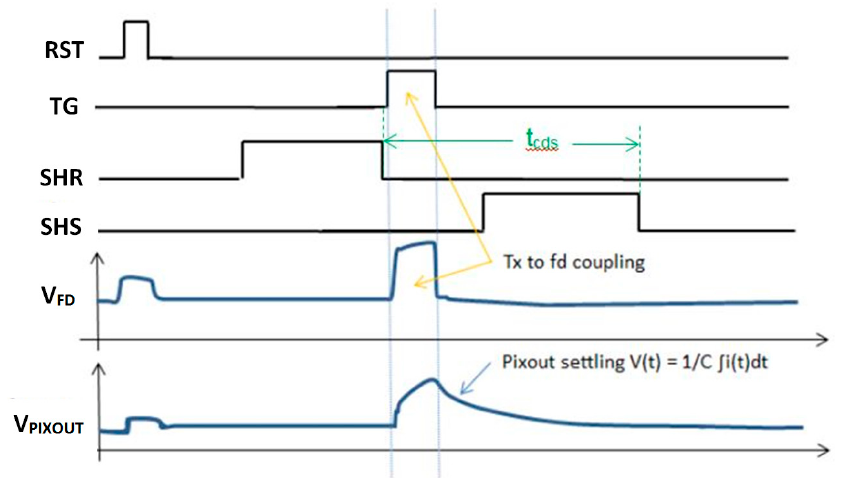
Figure 1. Conventional pixel readout timing diagram and output waveform. TG feed ‐ through limits small signal settling time. small signal settling